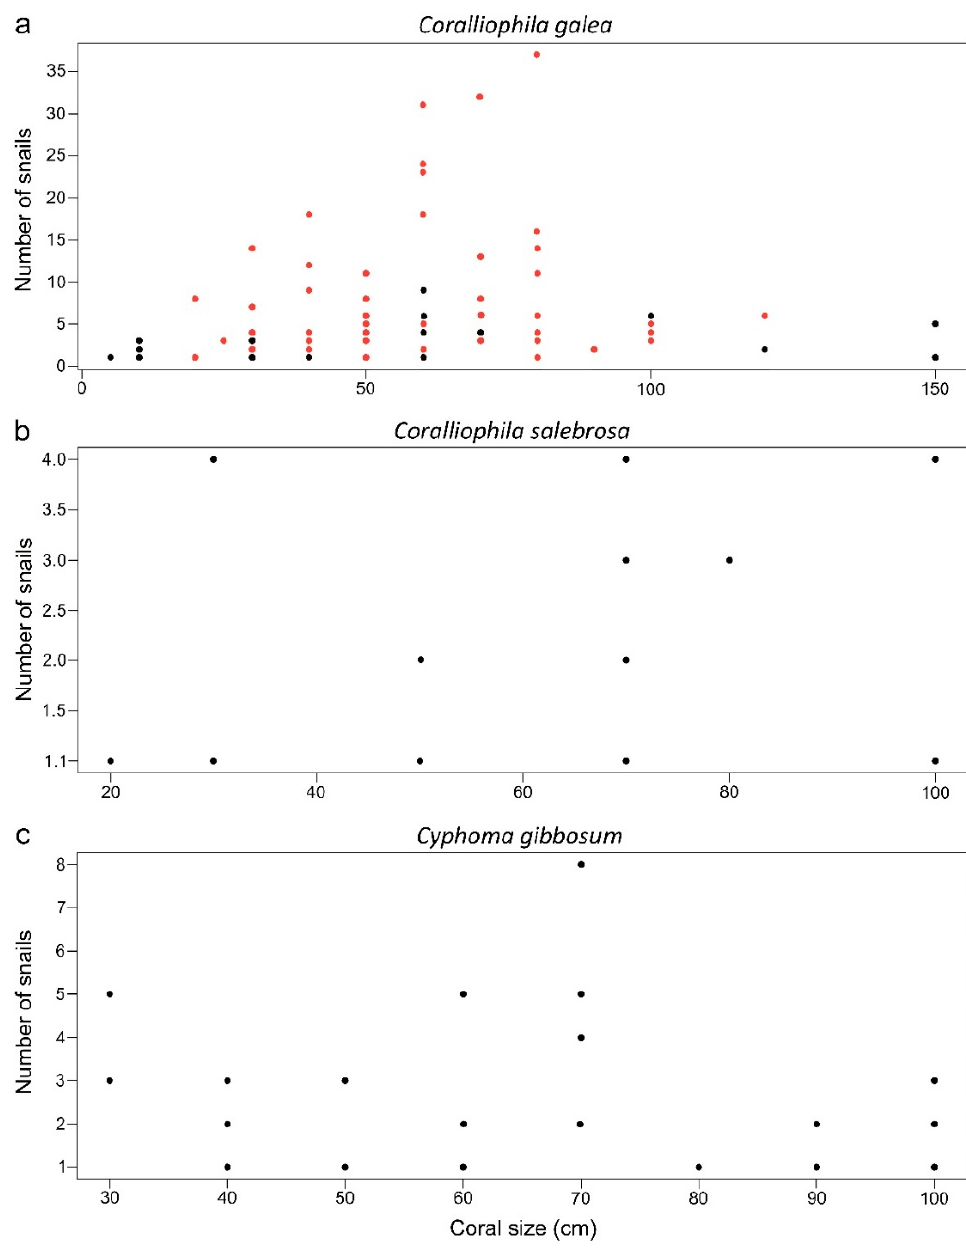
Figure 5. Linear regression of snail numbers and coral size for three snails species. Each dot represents an observation of a snail colony on a coral. For Coralliophila galea , the red points indicate observations on the coral species Orbicella annularis. The correlations are not significant.